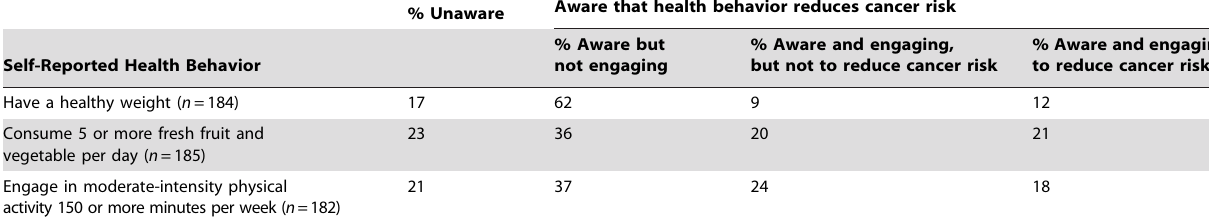
Table 2. Stage of Behavior Change.